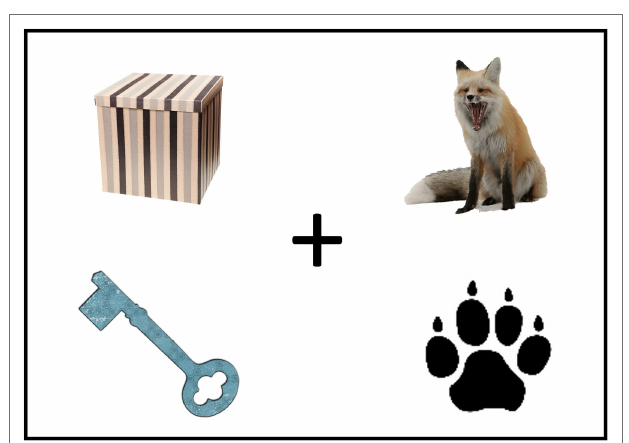
FIGURE 1 | Recreation of the example screen from the visual world task for the congruent sentence She put the toys in the box. For copyright reasons the original figure cannot be reproduced, but is available upon request to the corresponding author. Images sourced from